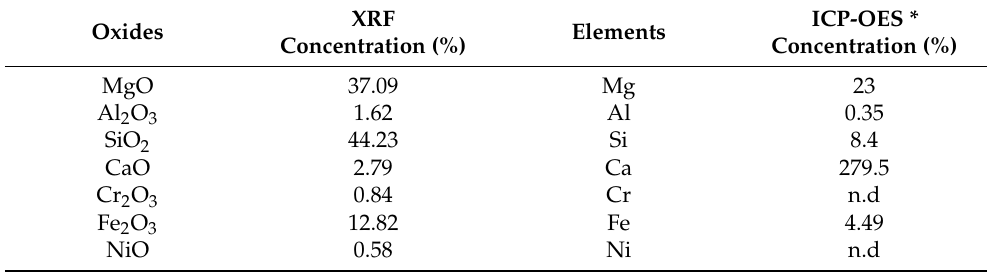
Table 2. Chemical composition of SERP.